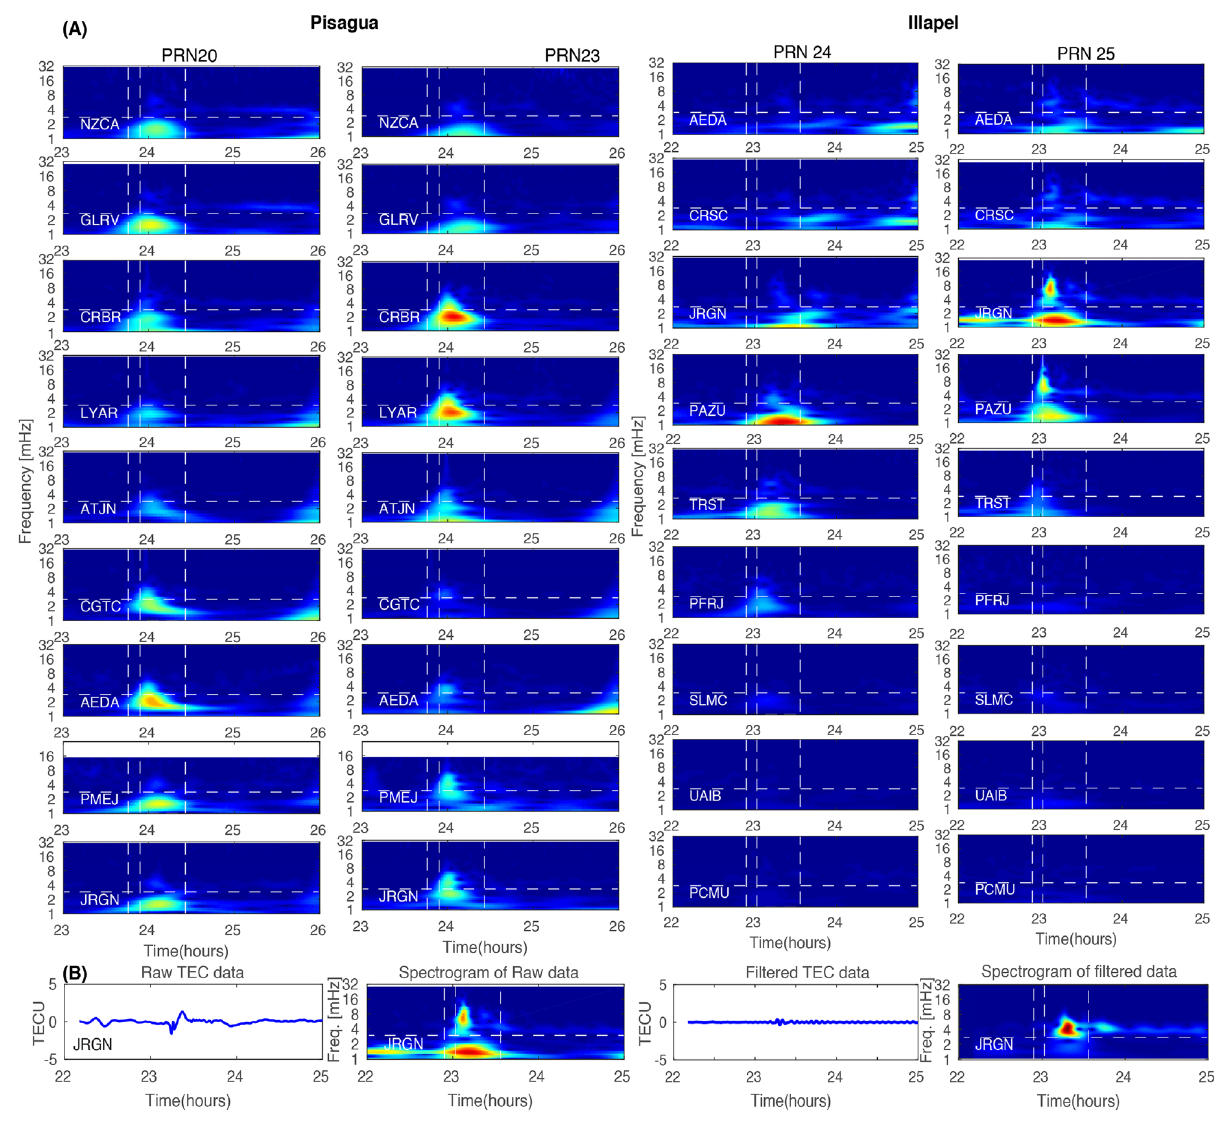
Figure 4. (A) Spectrogram of the residual TEC changes at randomly chosen GPS sites for PRNs 20 and 23 for the Pisagua and PRNs 24 and 25 for the Illapel earthquakes. The first dotted line represents the timing of the earthquakes; the second dotted line demarcates 8 min after the initiation of the earthquakes; and the third dotted line represents 40 min after the initiation of the earthquakes. (B) To identify the AW Rayleigh , the raw and filtered TEC of JRGN GPS site of PRN25 along with spectrogram